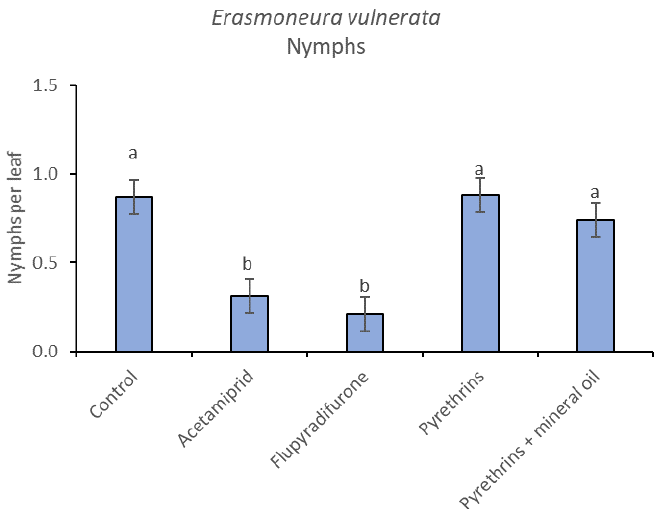
Figure 13. Least-square means ( ± std. err.) of Erasmoneura vulnerata nymphs observed on different treatments in the 2019 trial. Different letters indicate significant differences at t -test (α = 0.05.).